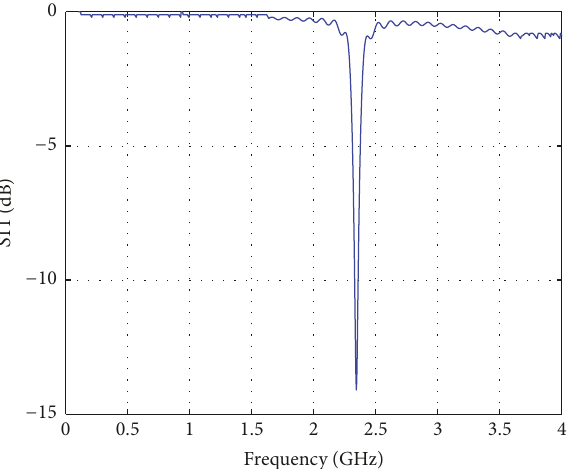
Figure 17: 𝑆 11 of the single band microstrip